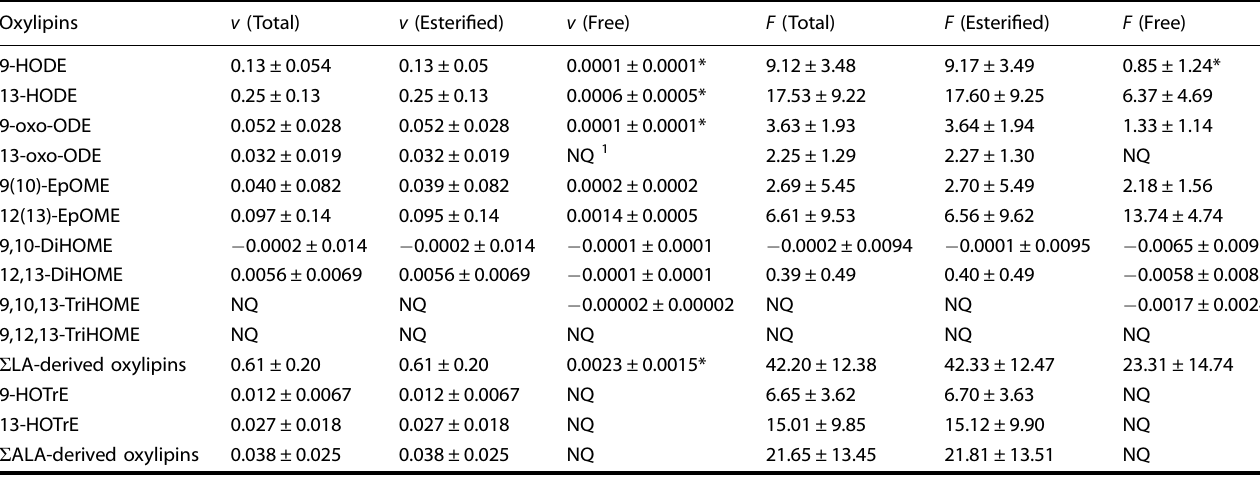
Table 5. Velocity ( v , pmol· μ L − 1 ·min − 1 ) and turnover ( F , ×10 – 8 ·min − 1 ) of total, free and esteri fi ed oxylipins in soybean oil heated for 24 h.